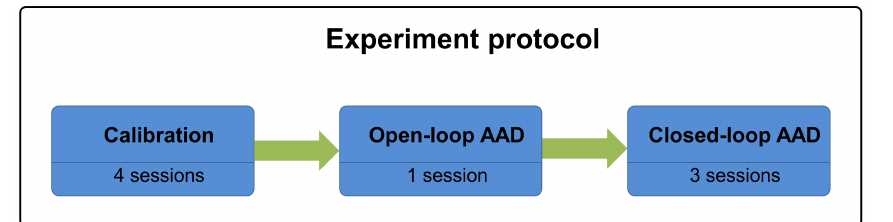
Figure 1. Experiment protocol used to calibrate and evaluate the cognitive-driven gain controller system. The experiment protocol consists of a calibration phase with four sessions, an open-loop AAD phase with one session and a closed-loop AAD phase with three